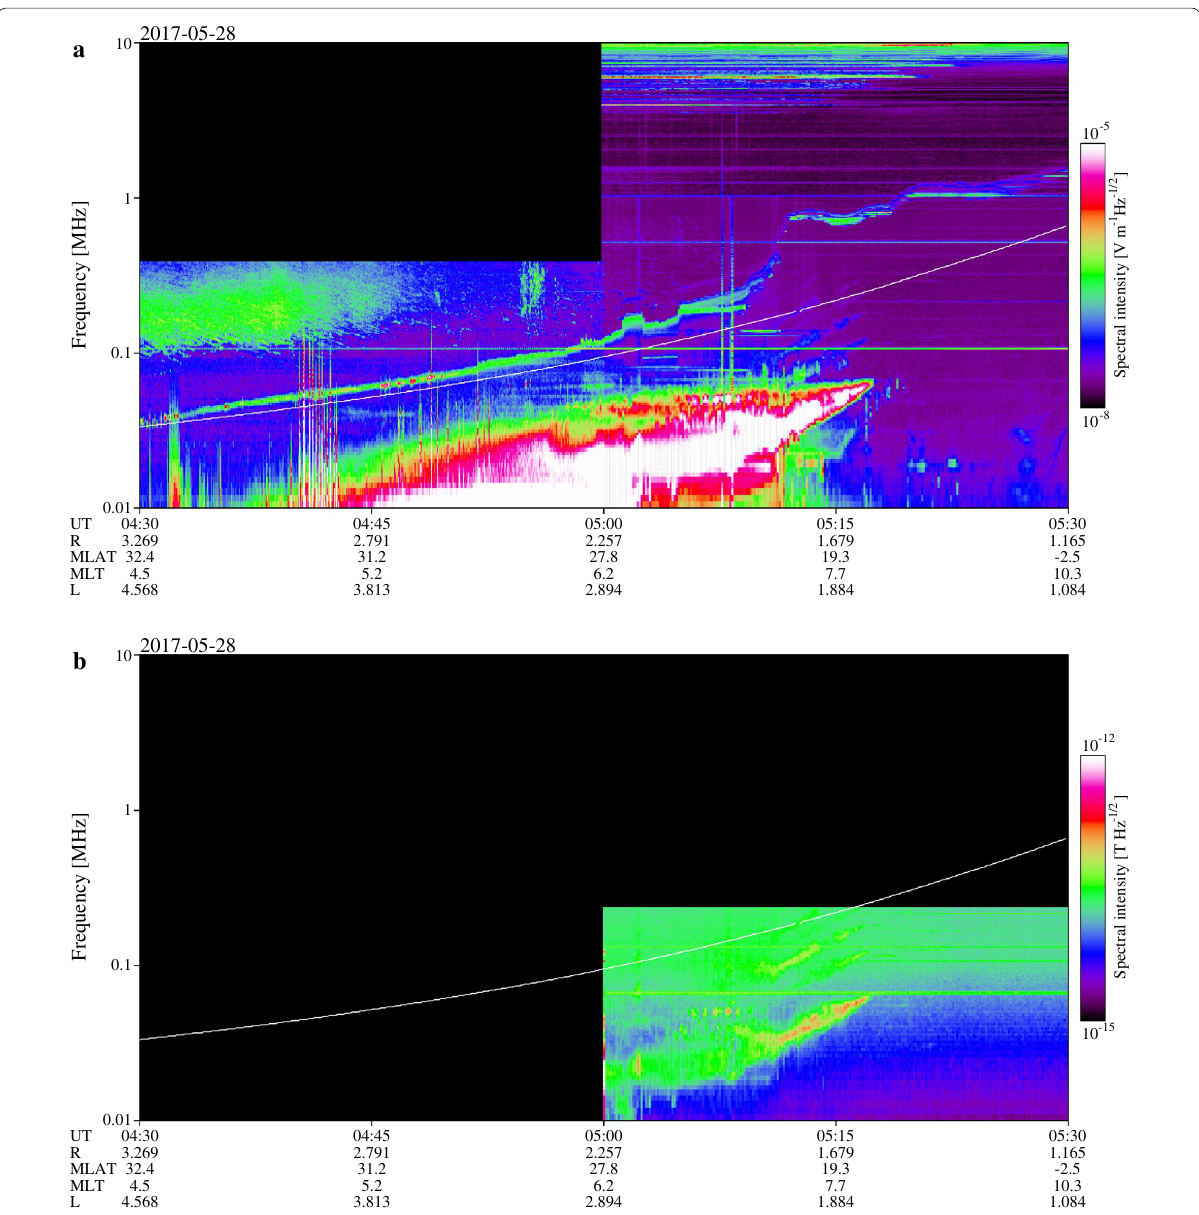
Fig. 4 Example of the spectrograms obtained in PP-1 and EB modes. The AC electric field is indicated in a . The AC magnetic field is indicated in b . The electron cyclotron frequency is indicated by white